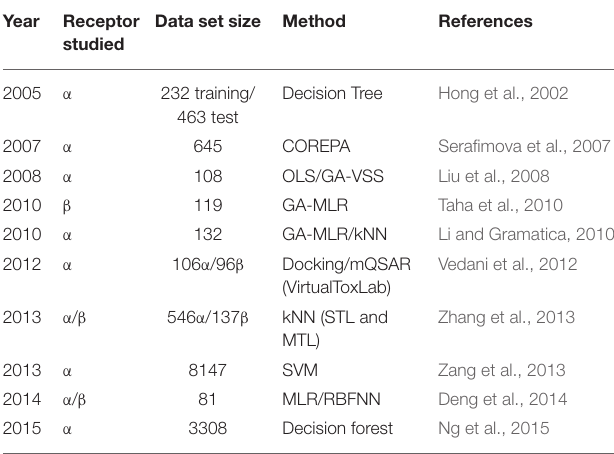
TABLE 1 | A sampling of QSAR studies on estrogen receptor